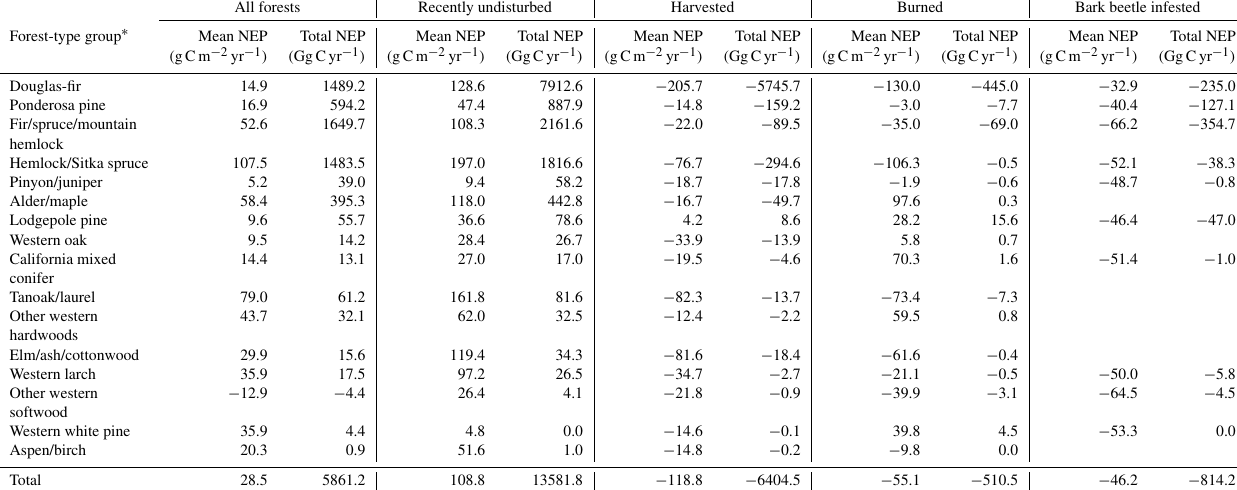
Table 3. Mean net ecosystem productivity (NEP) and total net carbon uptake by forest-type group in all forests, recently undisturbed forests, forests disturbed by harvest, fire, and bark beetle, which occurred during the time span of remote sensing disturbance products. All forests Recently undisturbed Harvested Burned Bark beetle infested